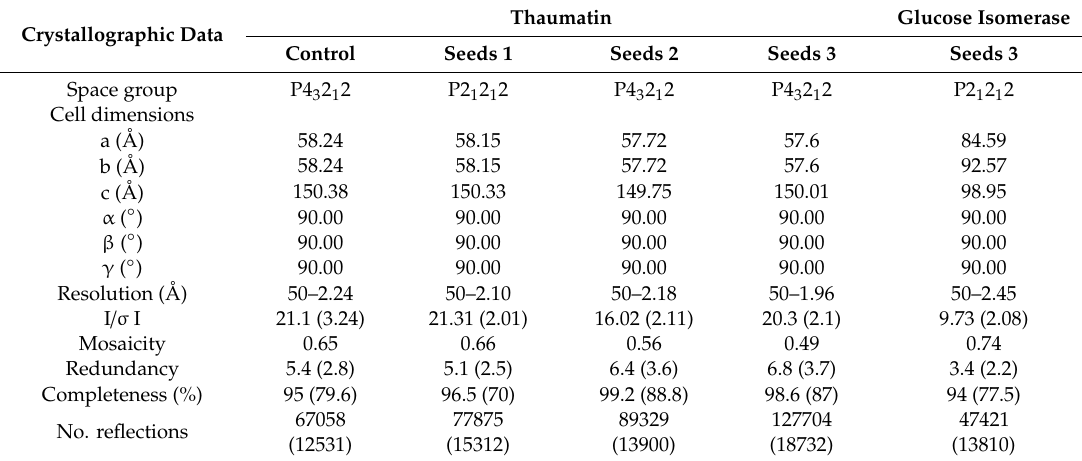
Table 3. Optimal di ff raction data of thaumatin and glucose isomerase crystals obtained from di ff erent